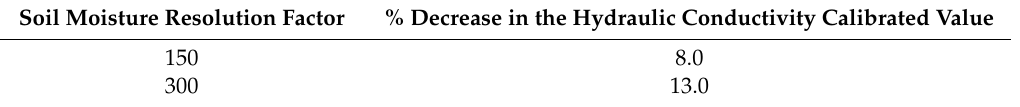
Table 3. Resolution of the initial soil moisture condition and its’ effect on the calibrated soil hydraulic conductivity parameter value.